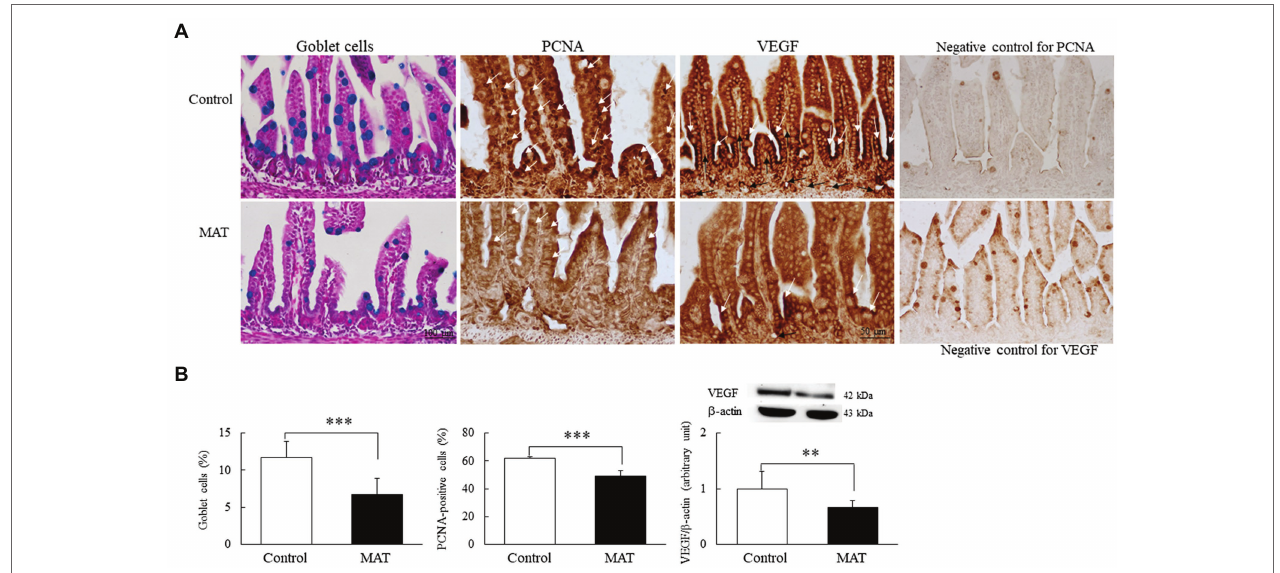
FIGURE 4 | Effects of MAT on (A) immunohistochemistry results and (B) results of quantitative analysis of goblet cells and PCNA-positive cells and Western blotting of VEGF in 7-day-old mice. The immunoreactivity for PCNA (white arrow) was localized to the nucleus and appeared along the epithelium of the intestinal mucosa and in the basal area of the intestinal crypts. Dark brown VEGF-positive staining (white arrow) was localized at the apical cytoplasm of the epithelial cells in both groups, and the VEGF-positive endothelial cells (black arrow) of blood vessels were observed in the lamina propria of the control group. The mice born to the control dams demonstrated more prominent immunoreactivity for PCNA and VEGF staining. The mice born to the antibiotic-treated dams exhibited significantly fewer mucus-positive goblet cells (blue stained) and PCNA-positive cells and significantly lower VEGF protein expression than did the mice born to the control dams